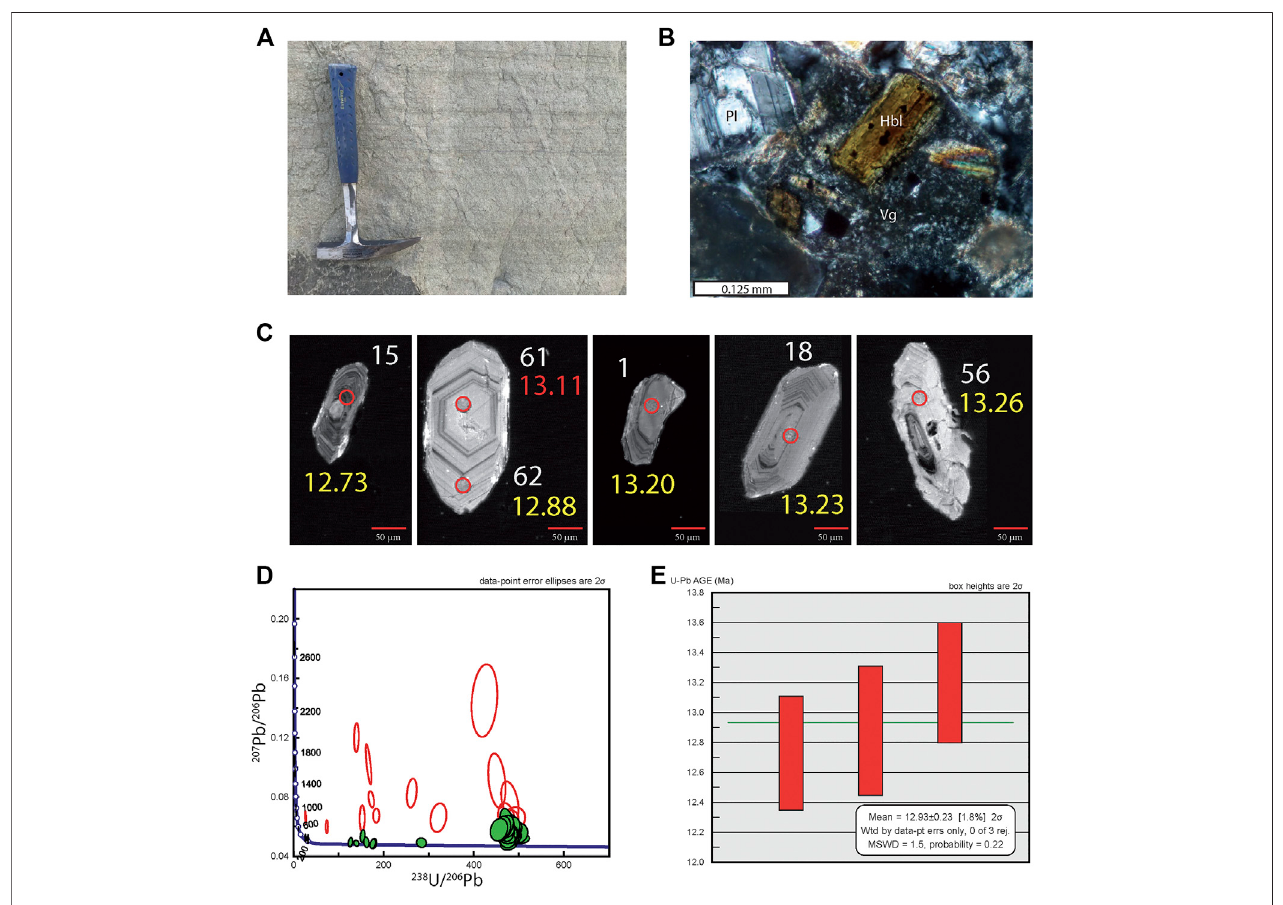
FIGURE 9 | Sample SEL-02 (coordinates: 3.27419 N, 75.1965 W). (A) Sampled strata in a plane parallel-bedded volcanoclastic unit near the top of the Tatacoa Beds ( Figure 3 ). (B) Photomicrograph showing fresh detrital components, plagioclase (PL), hornblende (Hbl), surrounded by volcanic glass (Vg). C) Cathodo- luminescence of the fi ve youngest zircons, note youngest ages in overgrowths (number in yellow: best age, number in red: discordant age). See SM2 for all images. (D) Tera – Wasserburg concordia diagram showing concordant (green, n (cid:1) 47) and discordant (red, n (cid:1) 15) U-Pb ages. (E) Detrital zircon maximum depositional age (MDA) calculated using weighted average of the youngest three U-Pb ages (Y3Z method of Coutts et al., 2019).